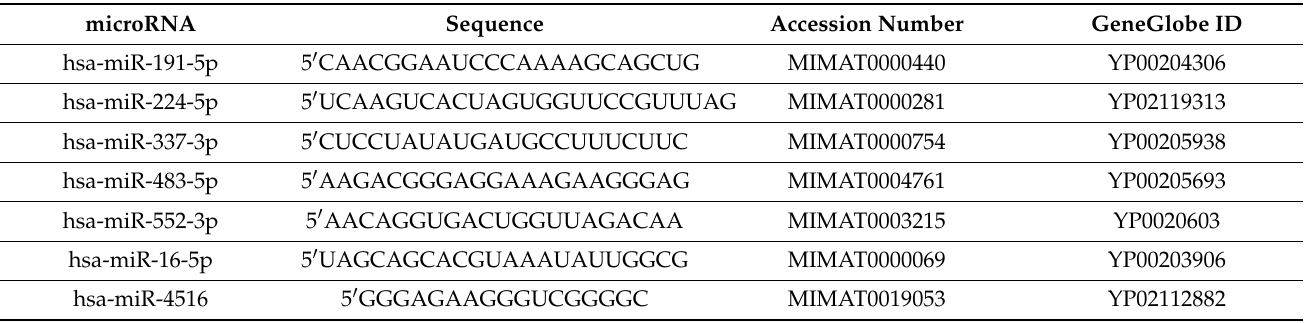
Table 1. miRNAs, their sequences, accession numbers, and GeneGlobe IDs by Qiagen (Hilden,